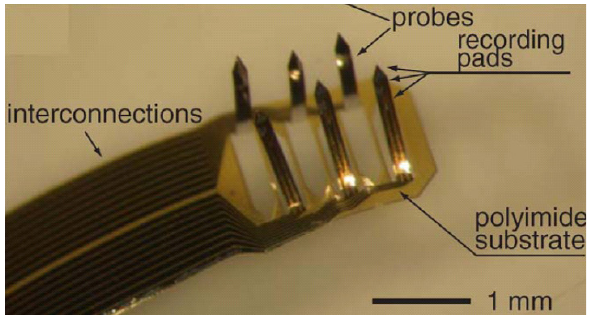
Figure 13. 3D flexible probe array after folding. The recording pads are vertically aligned. Reprinted from [111], with permission from Institute of Physics Publishing.